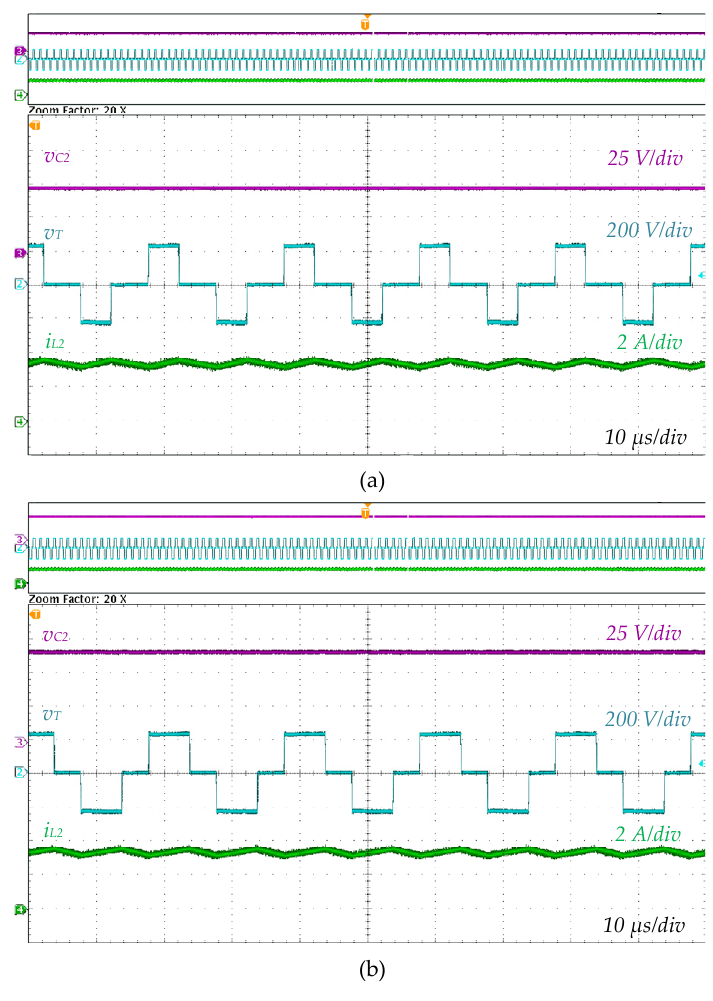
Figure 14. Charge current control during the batteries charge process: ( a ) Low state of charge and regulation of the charge current, ( b ) high state of charge and regulation of the charge current.